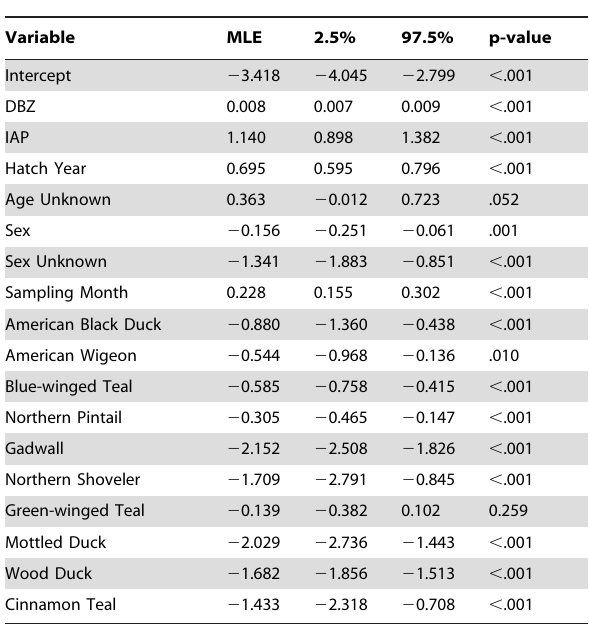
Table 3. Maximum likelihood estimates for covariate parameters in the global model examining the relationship between the probability a bird tested positive during the breeding season (April 1 to September 30) and the variables